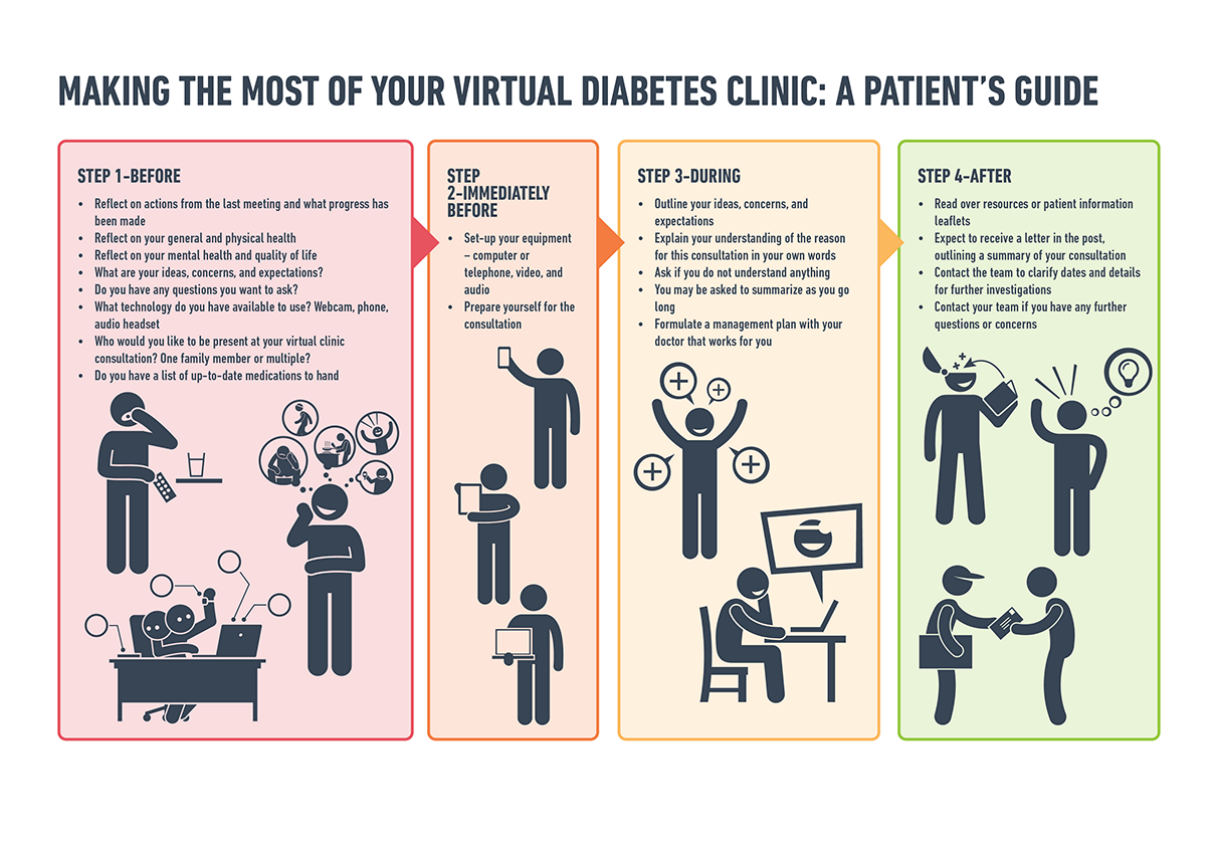
Figure 3. Making the most of your virtual diabetes clinic: a patient's